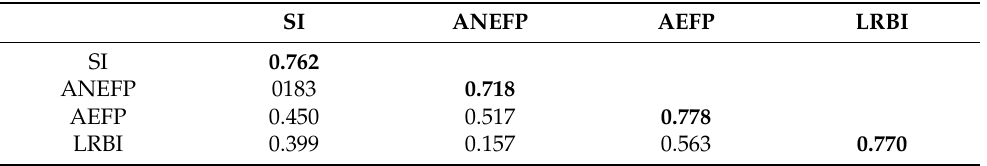
Table 4. Differential validity tests of the measurement scale.